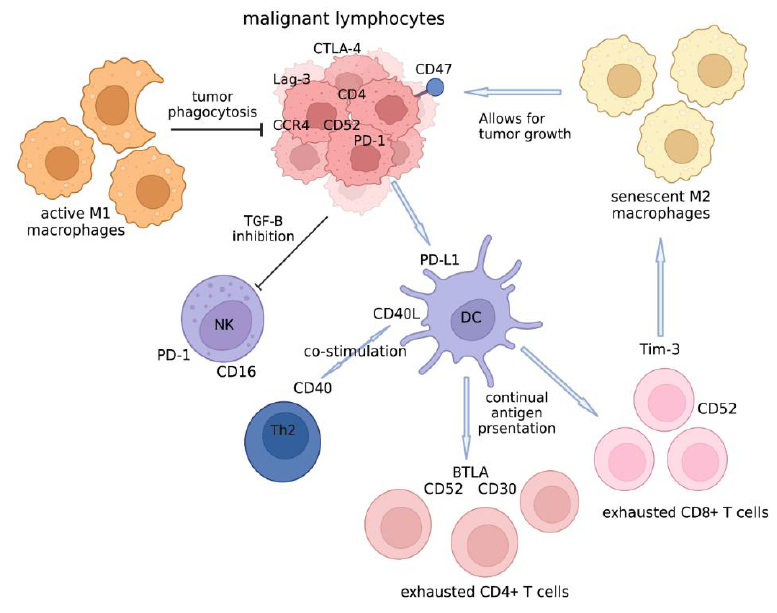
Figure 2. The tumor microenvironment of CTCL.